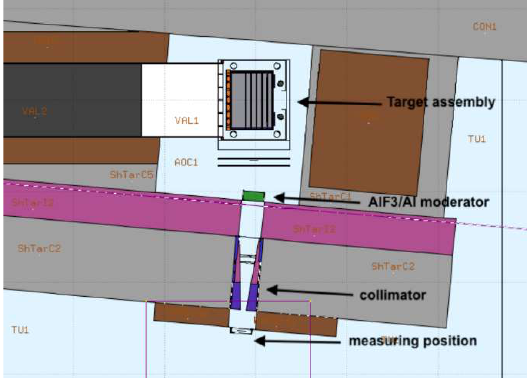
Fig. 2. n_TOF NEAR station, experimental site. From LoI CERN-INTC-2020-073.